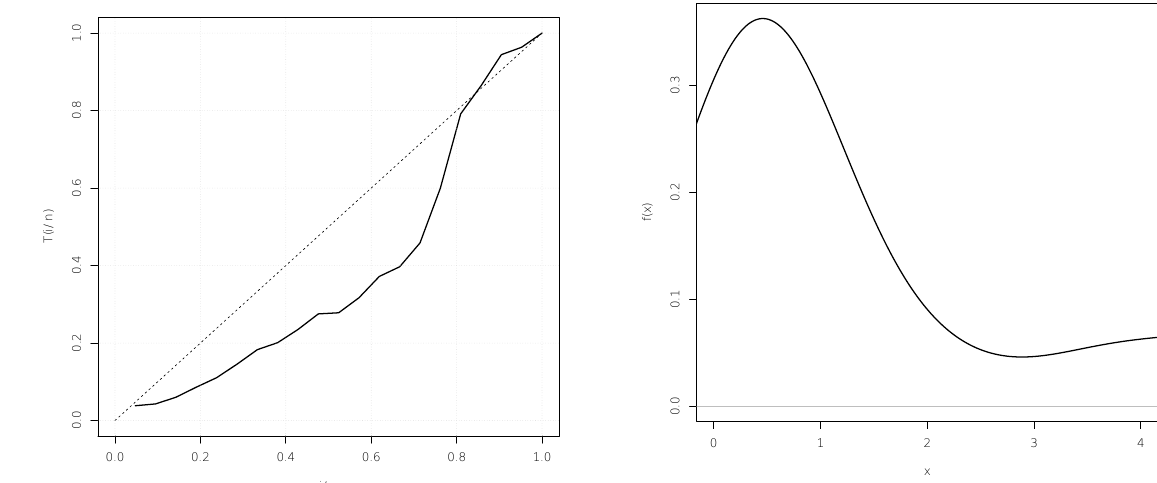
Figure 5 - The TTT plot for the time between failures (thousands of hours) of secondary reactor pumps.